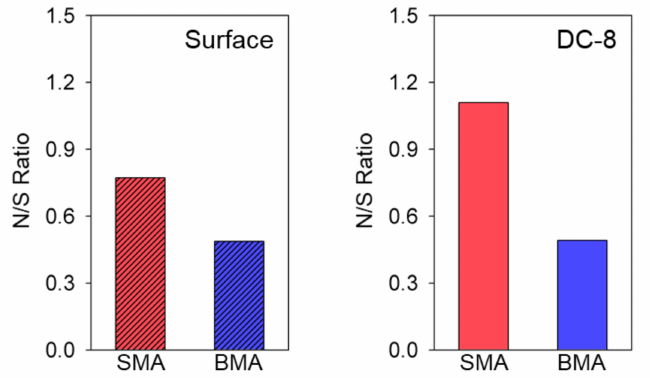
Figure 4. N/S ratios of aircraft measurements versus ground-based observations over SMA and BMA for the entire KORUS-AQ